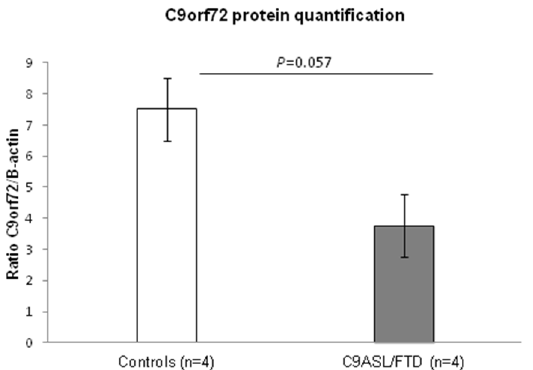
Figure 1. Analysis of C9orf72 protein levels in C9ALS/FTD patients (n = 4) and the control samples (n = 4) showed a 30% reduction in protein content in the patients. Results are expressed as means ± standard error of the mean (SEM).